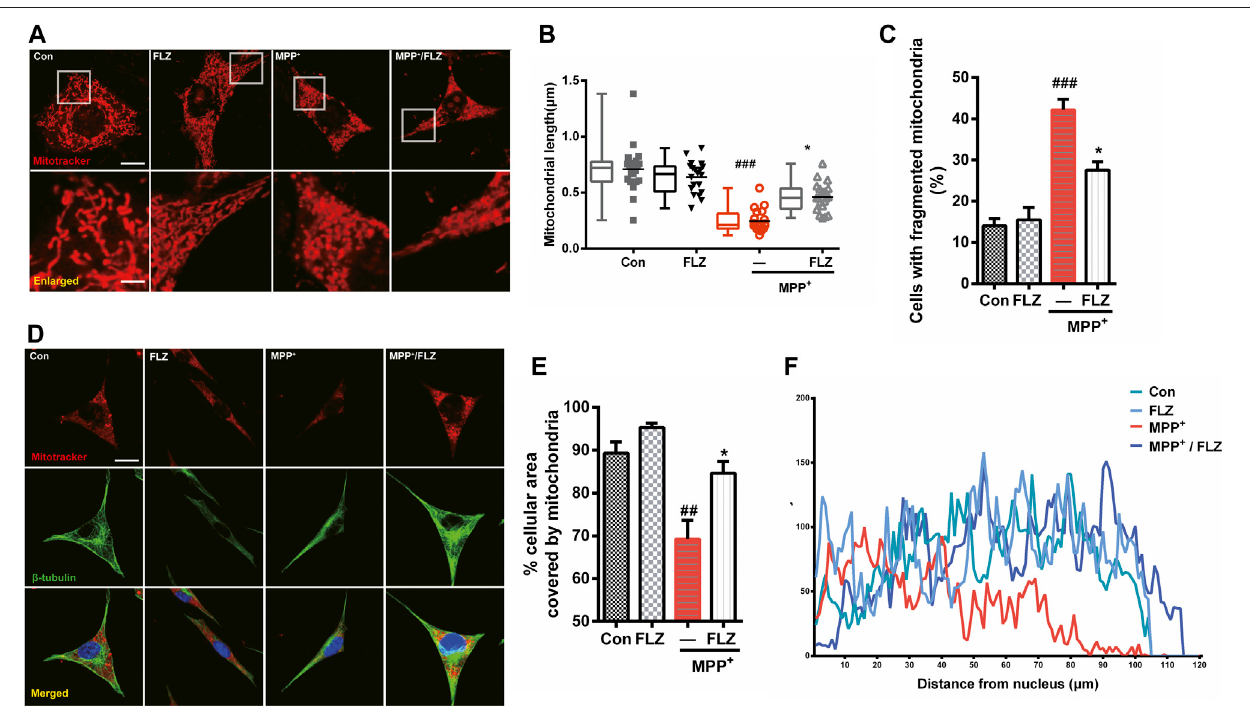
FIGURE 2 | FLZ treatment reduced MPP + -induced mitochondrial fragmentation and abnormal mitochondrial distribution. Cultured SH-SY5Y cells were treated with FLZ (10 μ M) for 30 min and then exposed to MPP + (2 mM) for 4 h (A) Mitochondrial morphology was analyzed by a confocal microscope. Cells were stained with mitotracker (red) and DAPI (blue) (scale bar: up:15 μ m, down:3 μ m). (B) Statistical analysisof mitochondrial lengthwasmeasured byImage-pro Plussoftware.Dataare presentedasthemeans ± SEMfrom4independentexperimentsof20 – 30randomselectedcells (C) Thepercentageofcellswithfragmentedmitochondriarelative to thetotal number ofcells wascounted byan observer blinded totheexperimentalconditions. Atleast 200cellsper groupwere counted. (D) Mitochondrial distribution was analyzed by a confocal microscope. Cells were stained with mitotracker (red) and DAPI (blue) (scale bar: 20 μ m). (E) Statistical analysis of the percentage of cellular areacoveredbymitochondriaweremeasuredbyImageJSoftware.Dataarepresentedasthemeans ± SEMfrom4independentexperimentsof20 – 30randomselected cells (F) Shownarerepresentativedataofmitochondria(red fl uorescence)distribution.One-wayANOVAfollowedbyTukeyposthoccomparisonstestswereperformed in all statistical analyses. ## p < 0.01 and ### p < 0.001 vs. Control group, * p < 0.05 vs. MPP + treated group.